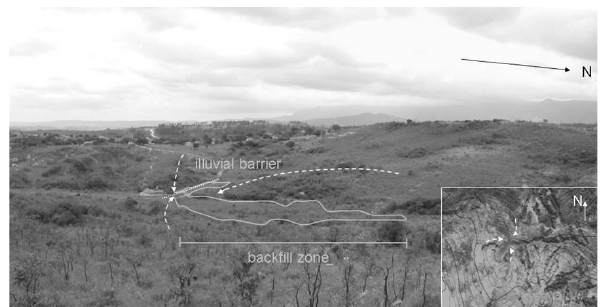
Fig. 18. South facing view of the Manalana wetland (solid line) with proposed model for clay-plug development highlighting hills- lope confinement zones and illuviation pathways (dashed line) and illuvial barrier (dotted line). Inset represent aerial view of hillslope confinement